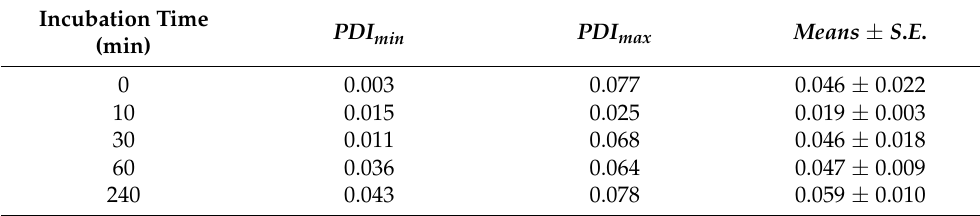
Table 1. Polydispersity index (PDI) of PS NPs and the PC.